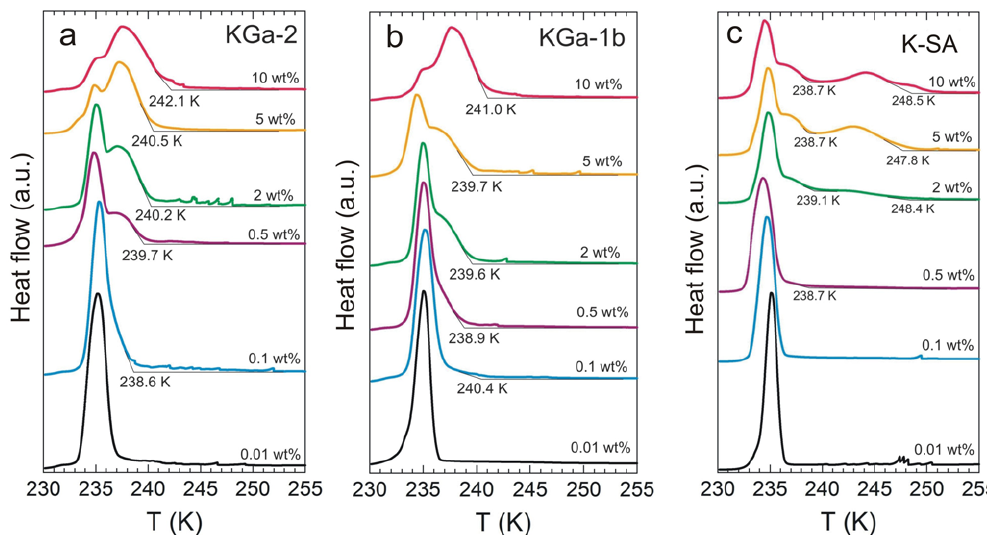
Fig. 3. DSC thermograms of KGa-2 (panel a ), KGa-1b (panel b ) and K-SA (panel c ). Curves are shown with different offsets for clarity. Suspension concentrations and onsets of heterogeneous freezing are indicated above and below the curves, respectively. The onset of the freezing peaks ( T on ) is given by the intersection of the two tangent lines (thin black lines) for each